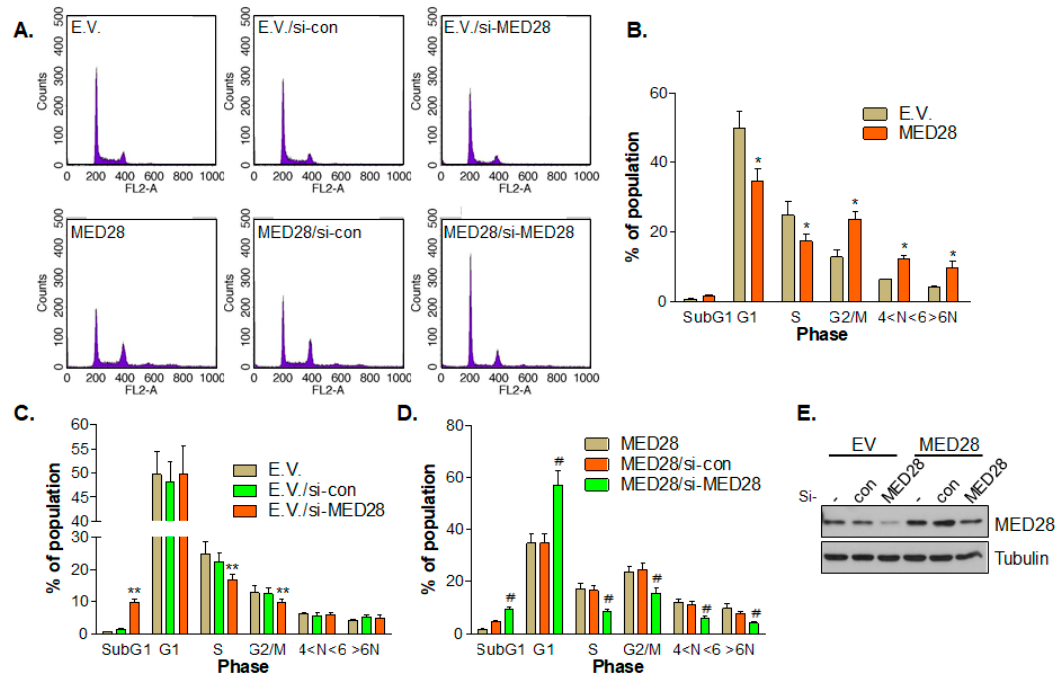
Figure 4. MED28 controls the cell cycle. ( A ) The stable HeLa cell lines harboring empty vector (E.V.) or overexspressing MED28 were transfected with the control or MED28 si-RNA (20 nM) for 48 h and harvested for fluorescence-activated cell sorting (FACS) analysis to compare their DNA contents. Results from at least three independent experiments are presented ( n = 3). ( B – D ) The cell population in each phase was evaluated and presented (*, vs. E.V.-harboring cell population; **, vs. E.V./si-con-harboring cell population; #, vs. MED28/si-con-expressing cell population). Results from at least three independent experiments are depicted ( n = 3). ( E ) The overexpression or knockdown of MED28 was confirmed by immunoblotting. Tubulin was used as a loading control. The results are depicted as the mean ± SD. * p < 0.05, ** p < 0.01, and # p < 0.01.